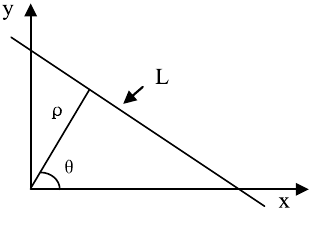
Fig. 1. Hough transform